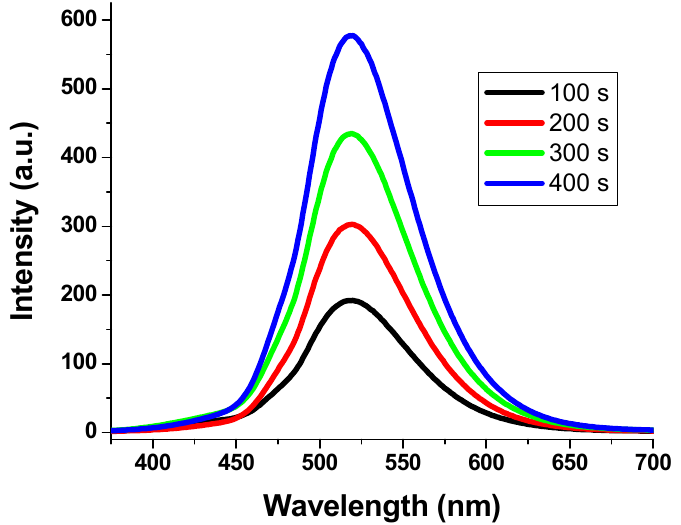
Figure 5. Emission spectra of LA 6 with increasing the duration of ultraviolet illumination (100–400 s).